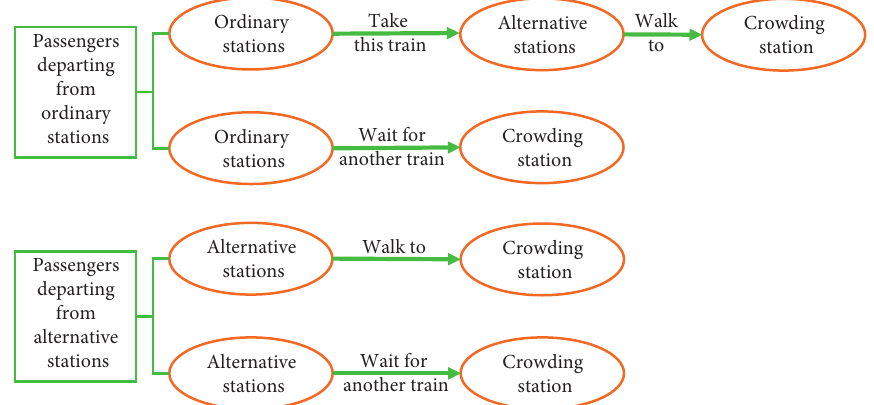
Figure 2: Different ways to arrive at the crowding station when train stop-skipping strategy is